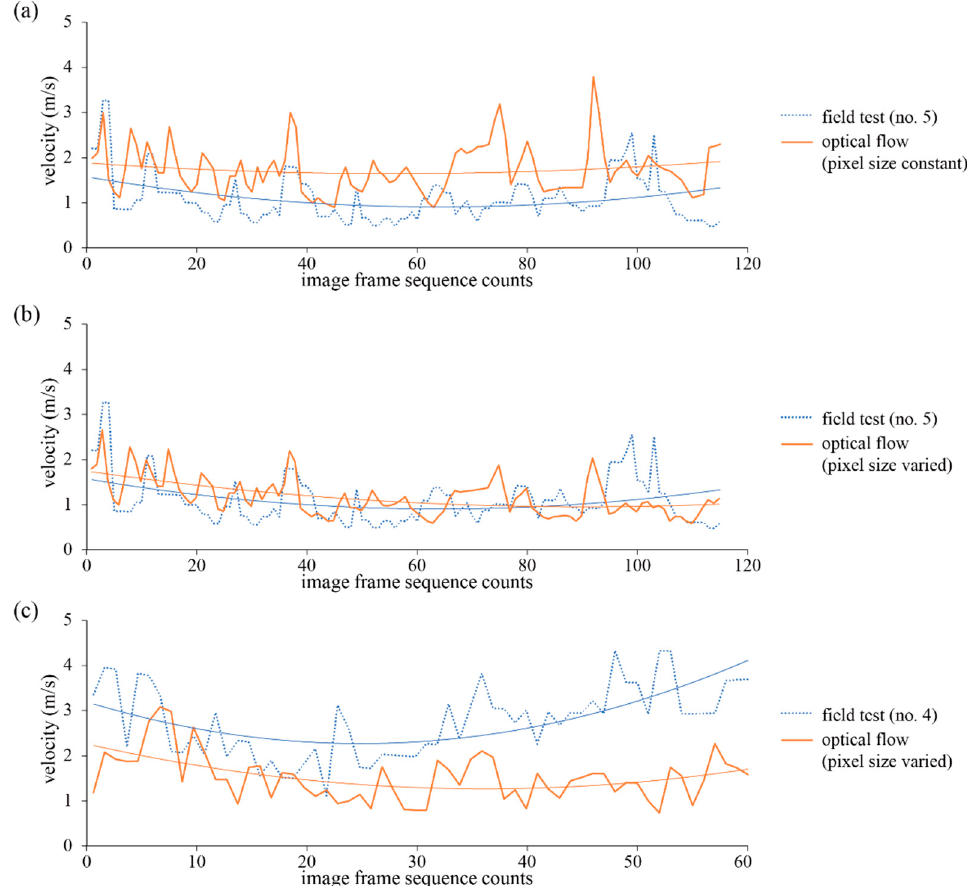
Figure 11. Comparison between optical flow results and calculation by observation with regard to the velocity of rockfalls: ( a ) for test #5 (sliding mode) using constant pixel size; ( b ) for test #5 using pixel sizes obtained from photogrammetric 3D topography; ( c ) for test #4 (bouncing mode).